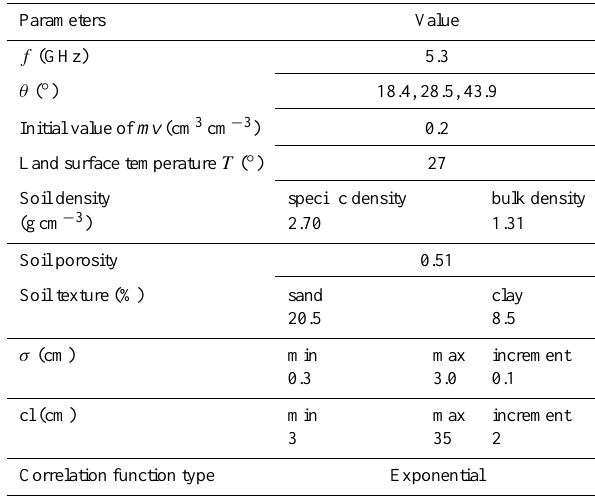
Table 2. Summary of the parameter values used in the Dobson dielectric mixing model and the AIEM. Figure 1. Locations of the Linze grassland in the arid region hydrology experiment area (right) in the Heihe River Basin (bottom left). 5